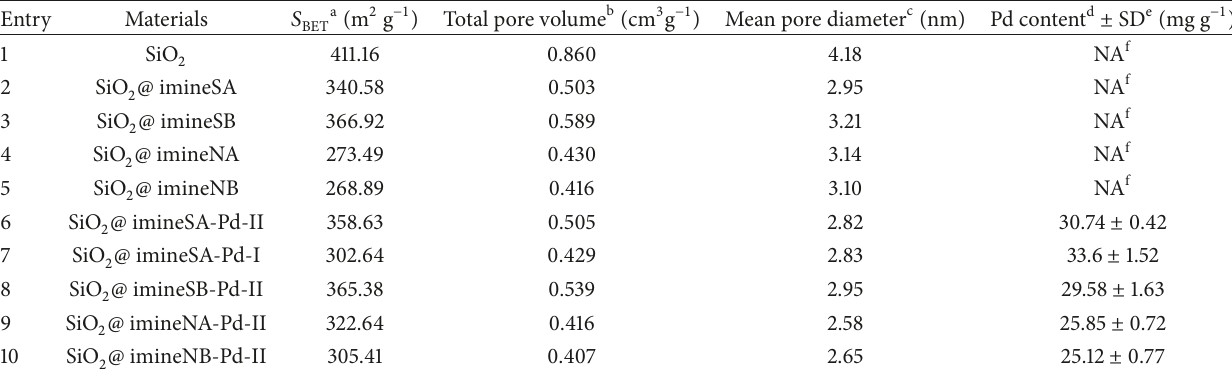
Table 1: Surface area, total pore volume, pore size distribution, and amount of Pd loaded on the surface of the silica-based materials. Entry Materials